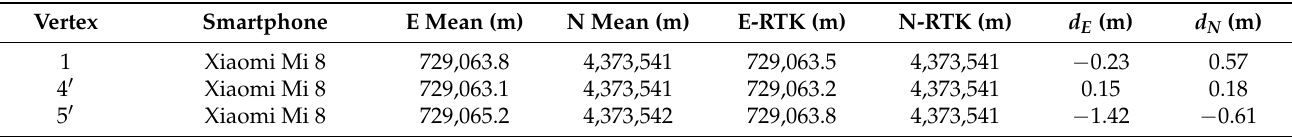
Table 5. Vertices 1, 4 (cid:48) , and 5 (cid:48) : East, North means of data collected, East, North coordinates from real-time GNSS techniques (E-RTK, N-RTK), and the differences between ( d E , d N ). Vertex